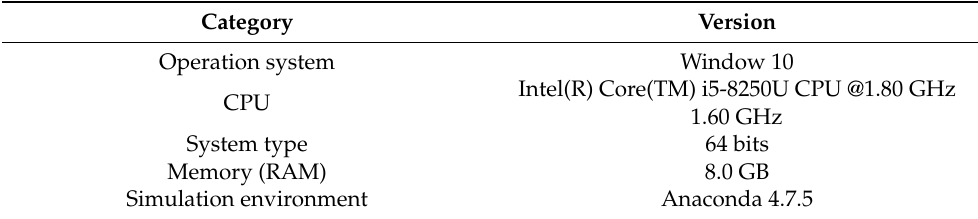
Table 1. Experimental environment.